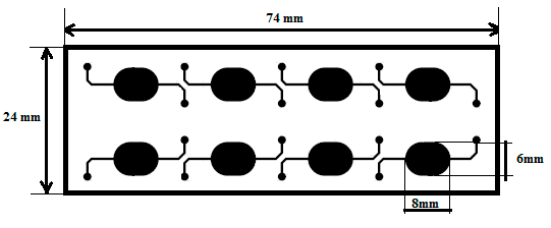
Figure 1. Top view of the microfluidic chip design [8].